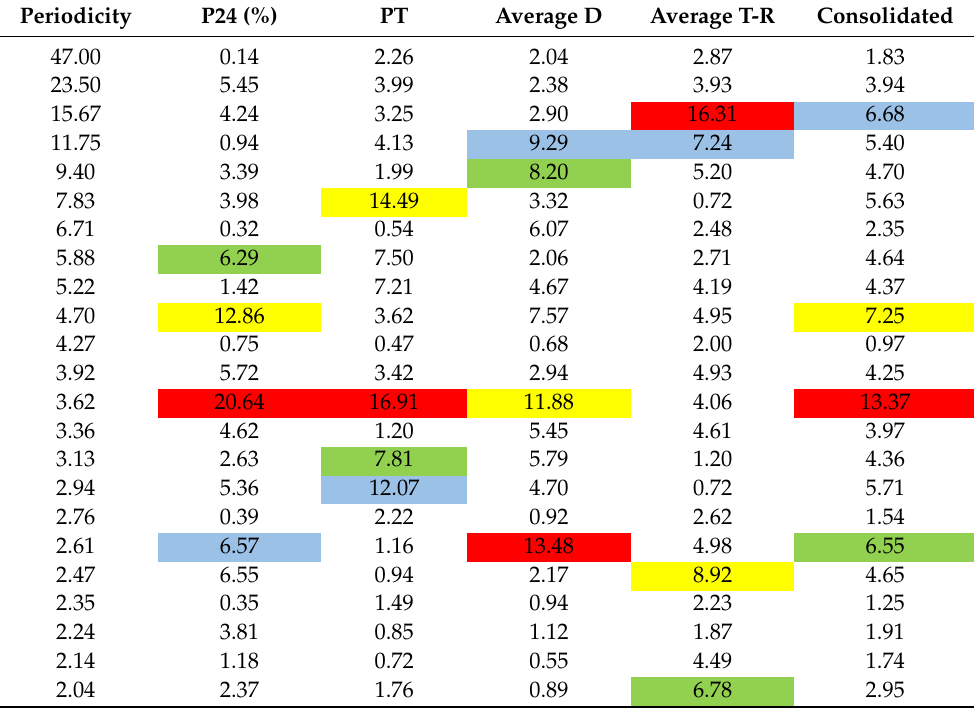
Table 9. Results of the relative importance of the periodicity by groups of variables (maximum precipitation in 24 h, total precipitation, maximum sub-daily intensities, and maximum, mean, and minimum temperatures) and the general consolidated. Periodicity P24 (%) PT Average D Average T-R